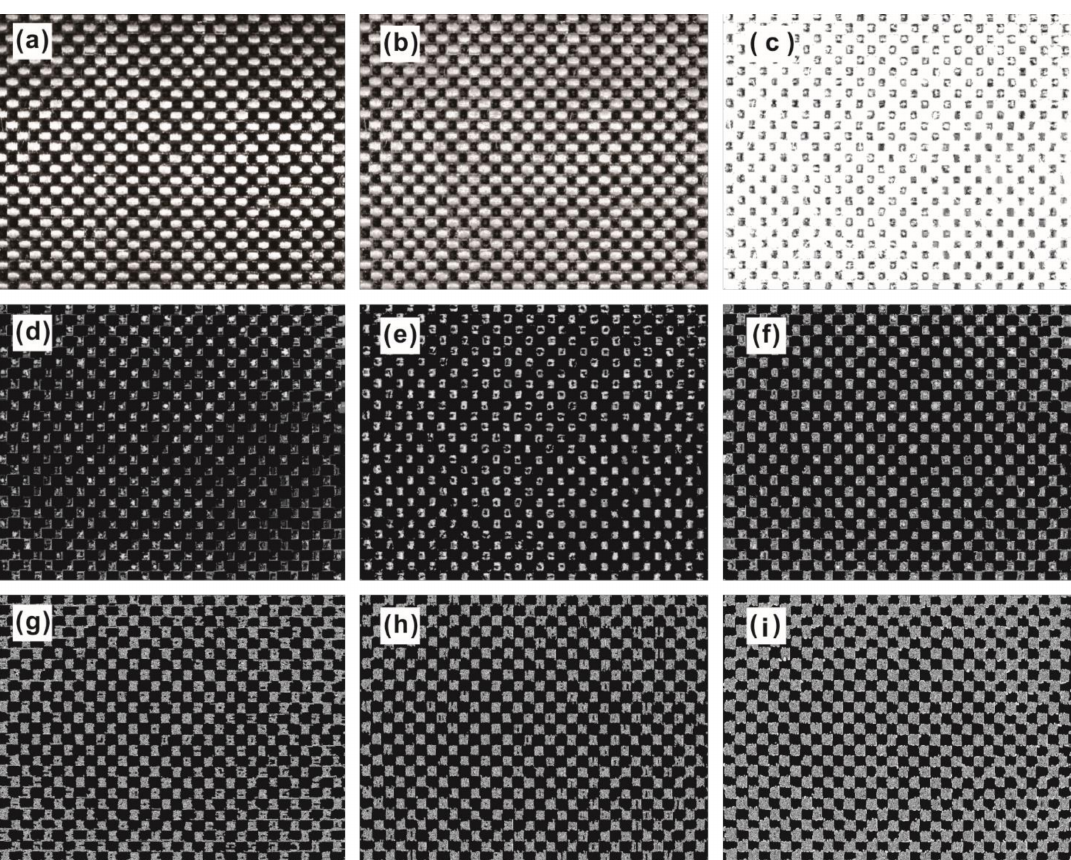
Figure 6. Image preprocessing steps: ( a ) original grayscale image; ( b ) histogram equalization; ( c ) box filtering; ( d ) top-hat transform; ( e ) bottom-hat transform; ( f ) gray-level morphology; ( g ) horizontal steerable filter; ( h ) vertical steerable filter; and ( i ) Gaussian filter.